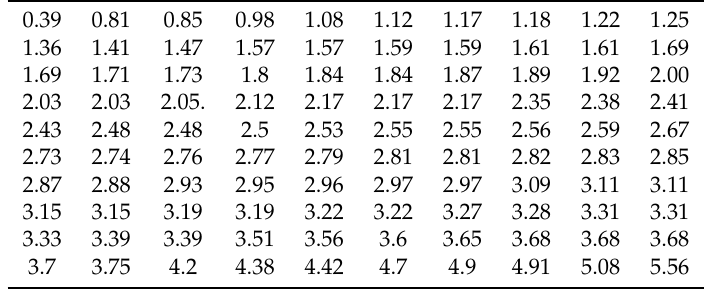
Table 8. Real data set of complete 100 observations on fracture stress of carbon fibres.